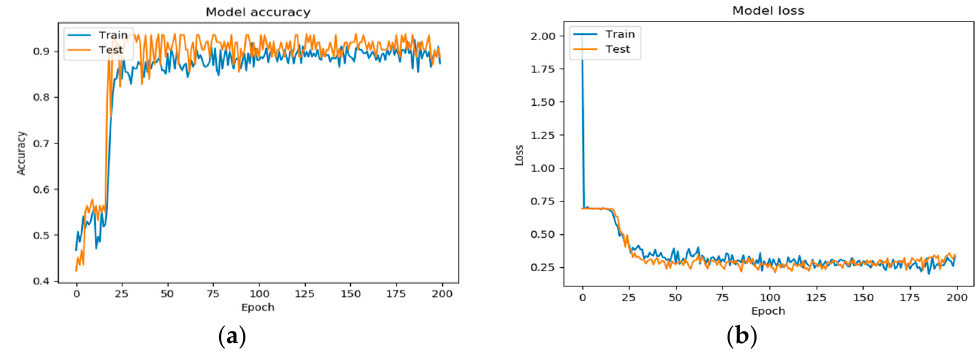
Figure 5. Precision curves for best CNN in RGB mode: ( a ) Accuracy and ( b ) Loss.